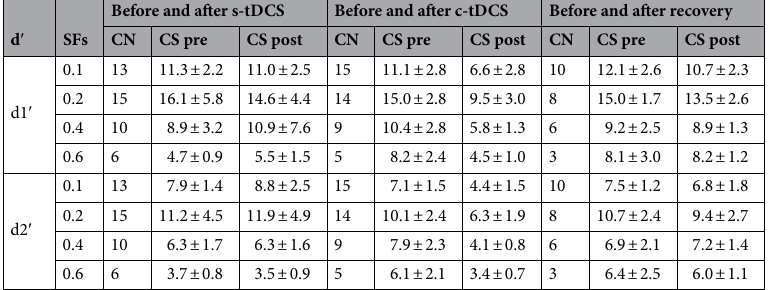
rons with different preferred spatial frequencies (SFs) was evaluated by the inverse of threshold contrast (TC) at two performance criteria (70.7% and 79.3%) both before and after s- and c-tDCS in A7 (Table 1). We also exam- ined the contrast sensitivity of some neurons by recording their response to stimuli with gradient contrasts after recovery from c-tDCS effect at the time point of 90 min after the end of c-tDCS 24–26 (Table 1). A part of neurons lost hold of recording before the time point of recovery. The post- versus pre-tDCS CS value of V1 neurons with different preferred SFs were compared at two performance criteria, respectively. Two-way ANOVA showed that the mean CS of V1 neurons after s-tDCS in A7 had no significant difference from that before s-tDCS [main effect of tDCS: F(1,160) = 0.217, p = 0.642]; the effect exhibited no interaction with SF [F(3,160) = 0.265, p = 0.85] and performance criterion [F(1,160) = 0.008, p = 0.929] although the mean CS had a significant variation between different SFs [F(3,160) = 37.889, p < 0.0001] and between different performance criteria [F(1,160) = 23.423, p < 0.0001] (Fig. 5A,B). Unlike s-tDCS, c-tDCS in A7 exerted an evident influence on CS of V1 neurons. Two-way ANOVA showed that the mean CS of V1 neurons after c-tDCS in A7 was significantly decreased compared with that before c-tDCS [main effect of tDCS: F(1,156) = 105.564, p < 0.0001]; this effect was independent of SF [F(3,156) = 0.799, p = 0.496] and performance criterion [F(1,156) = 2.968, p = 0.087] (Fig. 5C,D). We also compared the CS of some neurons (27/43) after recovery from c-tDCS effect with that before c-tDCS in A7. Two-way ANOVA showed that the mean CS of V1 neurons after recovery of c-tDCS effect displayed no significant difference from that before c-tDCS [main effect of tDCS: F(1,92) = 2.176, p = 0.144]; there was no significant interaction between c-tDCS effect and SF [F(3,92) = 0.606, p = 0.613] as well as between c-tDCS and performance criterion [F(1,92) = 0.084, p = 0.773]. The comparisons displayed above indicated that the contrast sensitivity of V1 neurons decreased significantly after suppressing top-down influence of A7 with c-tDCS, and could recover after the tDCS-induced top-down influence vanished. By contrast, s-tDCS in A7 had no impact on neuronal contrast sensitivity in the V1 cortex. Mechanisms of top‑down influence of A7. (S-Fig. 1). Based on the contrast-response function, contrast sensitivity changes of V1 neurons could be caused by following factors 18,27,28 : (1) contrast gain (C 50 ) due to a parallel shift of contrast-response function along x-axis of stimulus contrast; (2) change in the exponents of contrast response function (N); (3) change in the spontane- ous activity (M); (4) response gain due to alteration of maximum visually evoked response (R max ). Therefore, we systematically compared the best-fitting parameters of the hyperbolic ratio function [Eq. (1)] before and after top-down influence of A7 was modulated by c-tDCS. Because the top-down influence of A7 on contrast sensitiv- ity of V1 neurons was independent of neuronal preferred SFs, the comparison of parameter C 50 , N, M and R max was pooled across all studied neurons with different SFs. The C 50 value of most V1 neurons increased after c-tDCS relative to before c-tDCS in A7 (Fig. 6A). Two- way ANOVA showed that the mean C 50 of V1 neurons after c-tDCS in A7 was significantly higher than that before c-tDCS (mean increase of 39.4%) [main effect of tDCS: F(1,78) = 47.804, p < 0.0001], and this effect was independent of neuronal preferred SF [F(3,78) = 0.078, p = 0.972]. Conversely, the N (exponents) value of most V1 neurons reduced after c-tDCS relative to before c-tDCS in A7 (mean reduction of 20.8%) (Fig. 6B). ANOVA comparison exhibited that the mean N value of all neurons after c-tDCS in A7 was significantly decreased com- pared with that before c-tCS [F(1,78) = 58.324, p < 0.0001]; the effect had no interaction with neuronal preferred SF [F(3,78) = 0.176, p = 0.912]. The M value of most neurons after c-tDCS was equal or close to that before c-tDCS (Fig. 6C). ANOVA analysis displayed that the mean M value of all neurons after c-tDCS had no significant variation from that before c-tDCS [main effect of tDCS: F(1,78) = 0.071, p = 0.791]; there was no interaction between tDCS effect and neuronal SF [F(3,78) = 0.087, p = 0.967]. However, the R max value of most neurons was reduced (mean reduction of 22.6%) after c-tDCS relative to before c-tDCS in A7. ANOVA analysis exhibited that